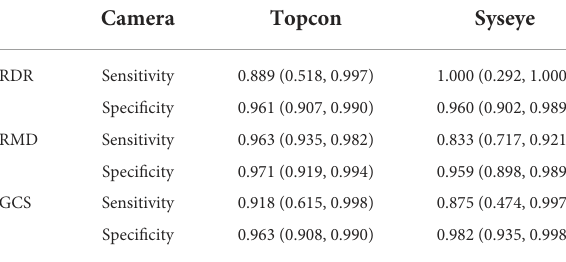
TABLE 9 Specificity values of AI-100 on Topcon and Syseye with PUMCH-NSDE mixed